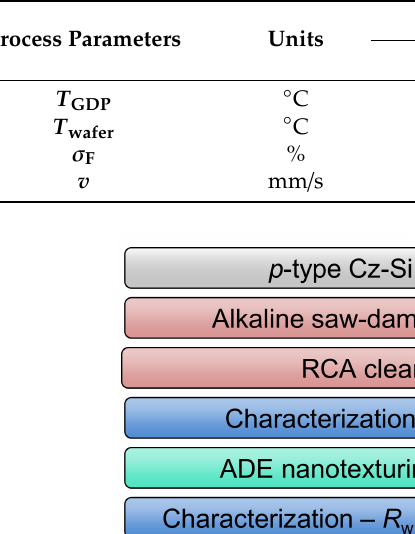
Table 1. Process parameters used for 3 × ( k − p ) experimental design.